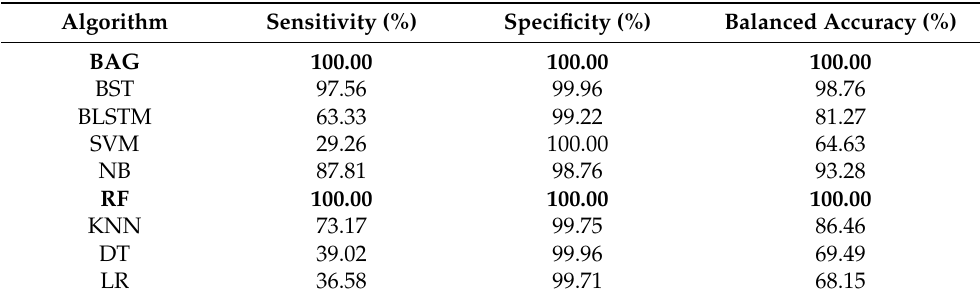
Table 4. Performance Metrics of AENN on BAG, BST, BLSTM, SVM, NB, RF, KNN, DT, and LR. The best results are shown in bold.